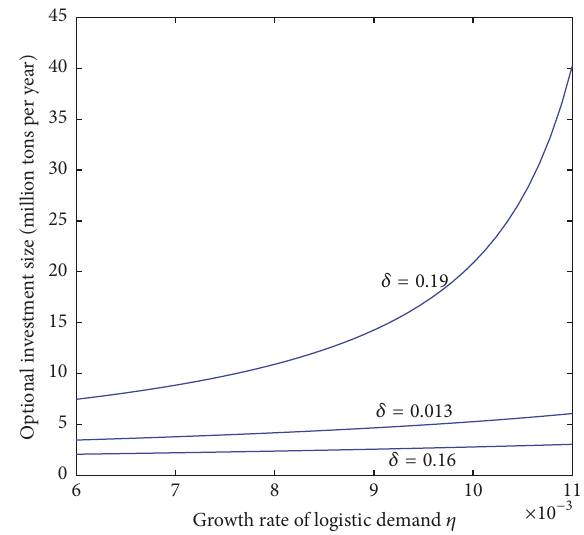
Figure 3: Change of the optimal size with the growth rate of logistic demand and